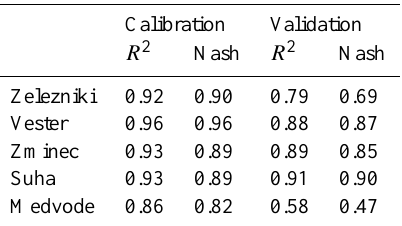
Table 3. Coefficient of determination and Nash-Sutcliffe estima- tors for calibration and validation periods. For Medvode only daily observed data were available.